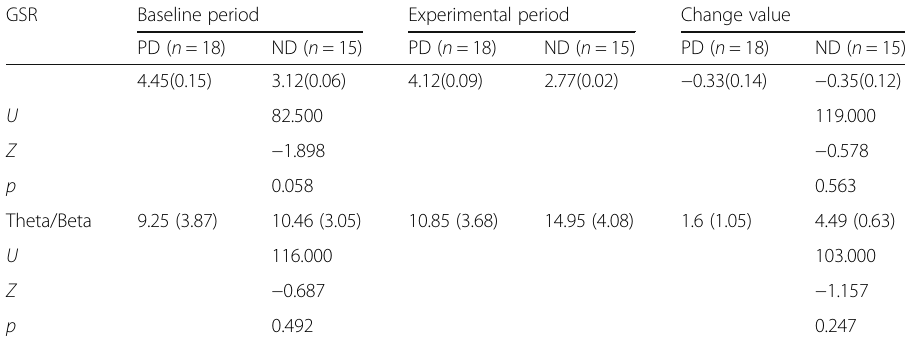
Table 3 Means and standard deviations of GSR and theta/beta for the two groups GSR Baseline period Experimental